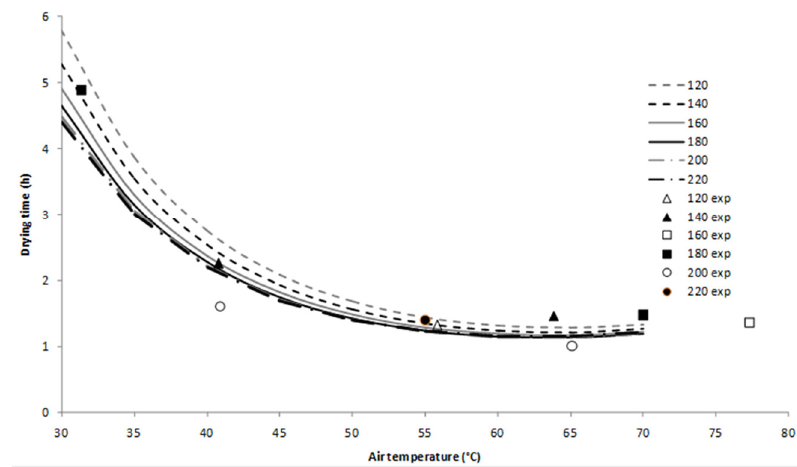
Figure 4. Drying time as a function of air temperature and flow rate (DOE equation (line) and experimental tests (points)).